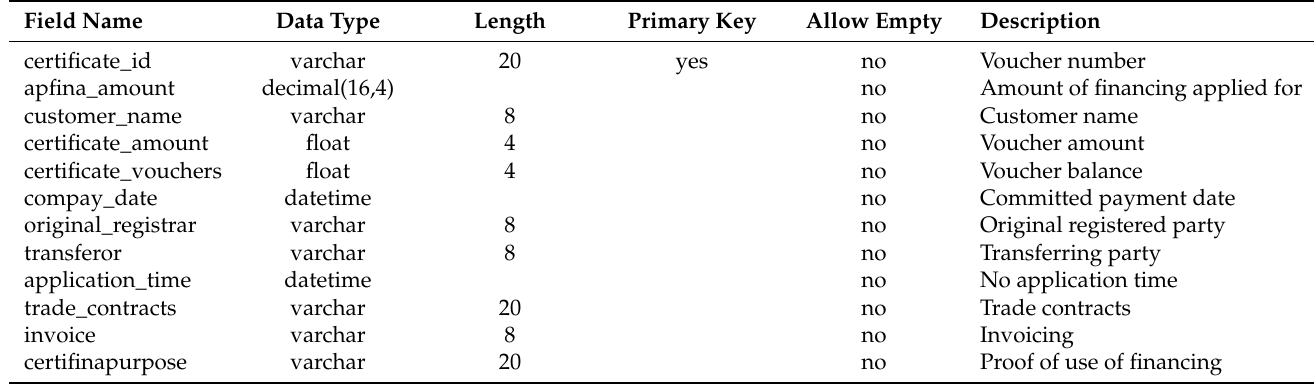
Table 1. Transaction summary